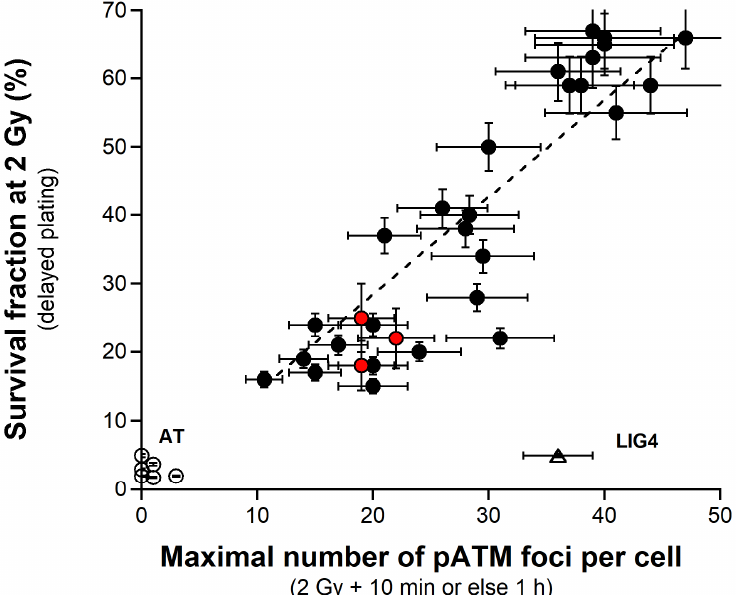
Figure 5. SF2 vs pATMmax relationship. By using historical data published in [45], the SF2 and the corresponding γ H2AX foci data assessed 24 h post-irradiation and obtained from 36 COPERNIC cell lines were plotted together (closed black circles). Each point corresponds to the mean ± standard error of the mean (SEM) of 3 independent triplicates, at least. The survival and pATM data from the RTS fibroblast cell lines shown in Figures 1 and 4A were added to the graph (red circles). The best data fit was obtained with the linear law: SF2 (pATMmax) = 1.422 × pATMmax; r 2 = 0.87 (dotted line).